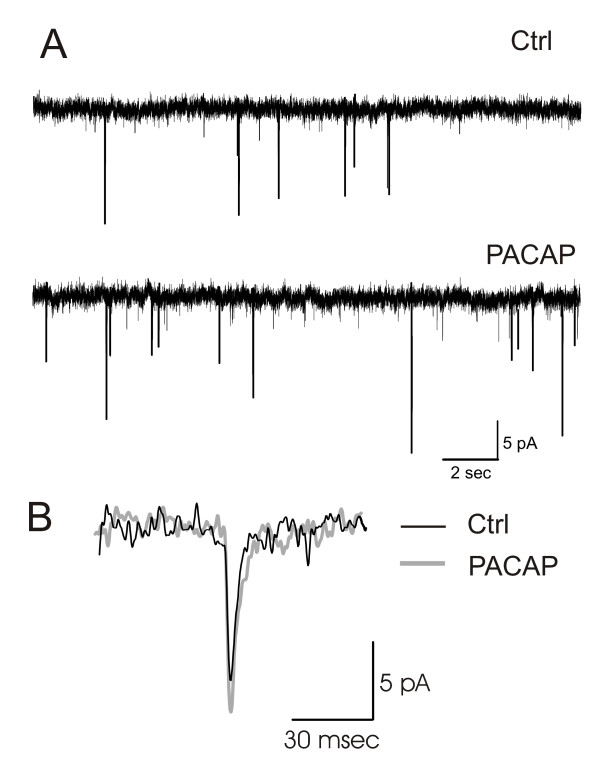
PACAP enhances the frequency and amplitude of sEPSCs recorded from mouse SCN neurons. Whole cell patch clamp recording techniques were used to measure the sEPSCs in ventral SCN neurons during the night (ZT 15–17). All experiments were carried out in presence of TTX (0.5 μM) and bicuculline (25 μM). (A) Top panel provides an example of sEPSCs recorded before and after treatment with PACAP (10 nM, 240 sec). PACAP increased the frequency (4 out of 6 neurons) and the amplitude (6 out of 6 neurons) of the sEPSCs. (B) Average sEPSC waveform recorded in an SCN neuron before and after treatment with PACAP (10 nM, 240 sec). PACAP increased the sEPSC amplitude by 20% ± 5 %.